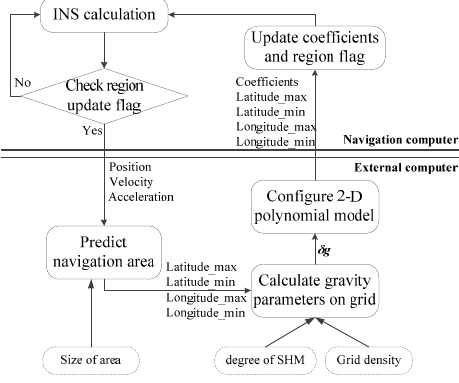
Figure 4. The scheme of model configuration in INS.